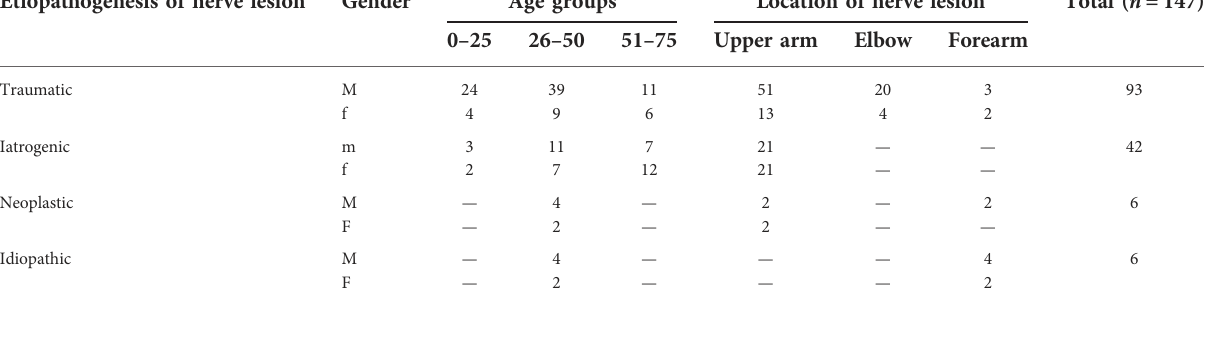
TABLE 2 Distribution of the patients with reference to etiology, among gender, age groups, and location of the nerve lesion. Etiopathogenesis of nerve lesion